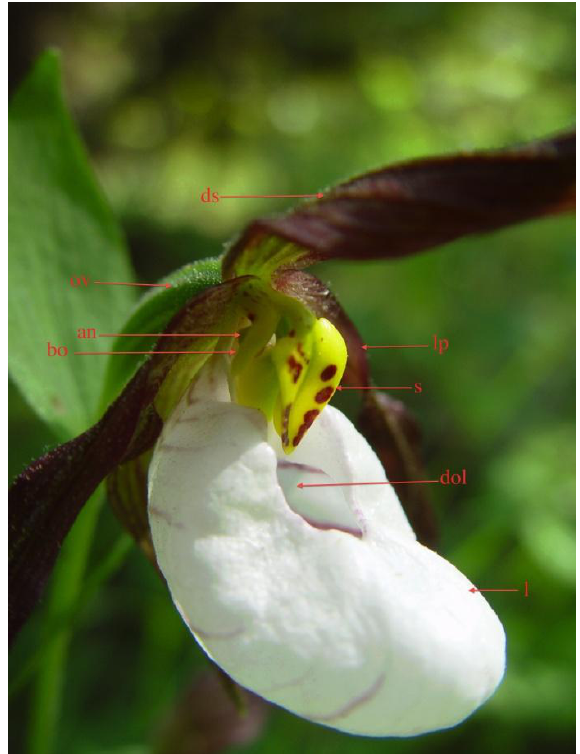
Figure 1. Flower of C. montanum: an = anther, bo = basal opening, dol = dorsal opening of labellum (note interior purple stripes), ds = dorsal sepal, l = labellum, lp = lateral petal, ov = ovary (Photograph by Nan